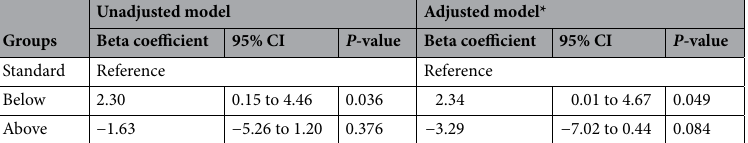
Table 3. Association between the dose groups and the length of hospital stay. Those who died during the index hospitalisation were excluded. BNP brain natriuretic peptide, CI , confidence interval. *Adjusted for age, sex, history of heart failure, and atrial fibrillation, the New York Heart Association class, systolic blood pressure, haemoglobin, serum creatinine, sodium, albumin, and log-transformed BNP.